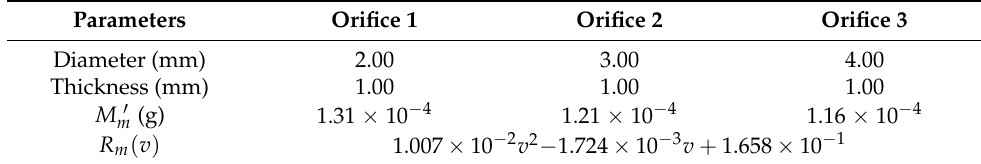
Table 1. Parameters of the orifices and the miniature loudspeaker.